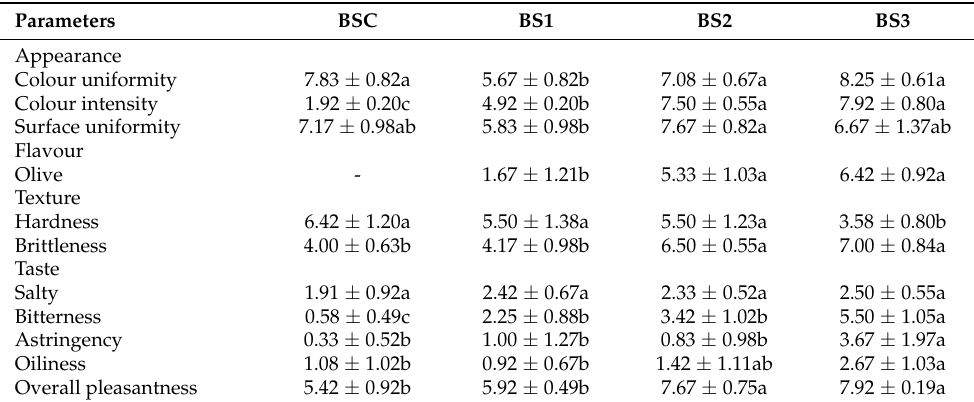
Table 5. Mean values, standard deviation, and results of statistical analysis of the sensorial analysis of GF